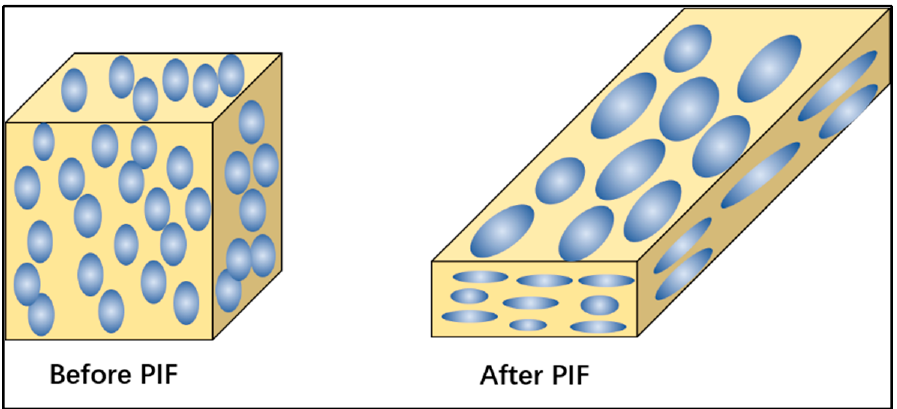
Figure 4. Crystal deformation mechanism diagram before and after PIF process .